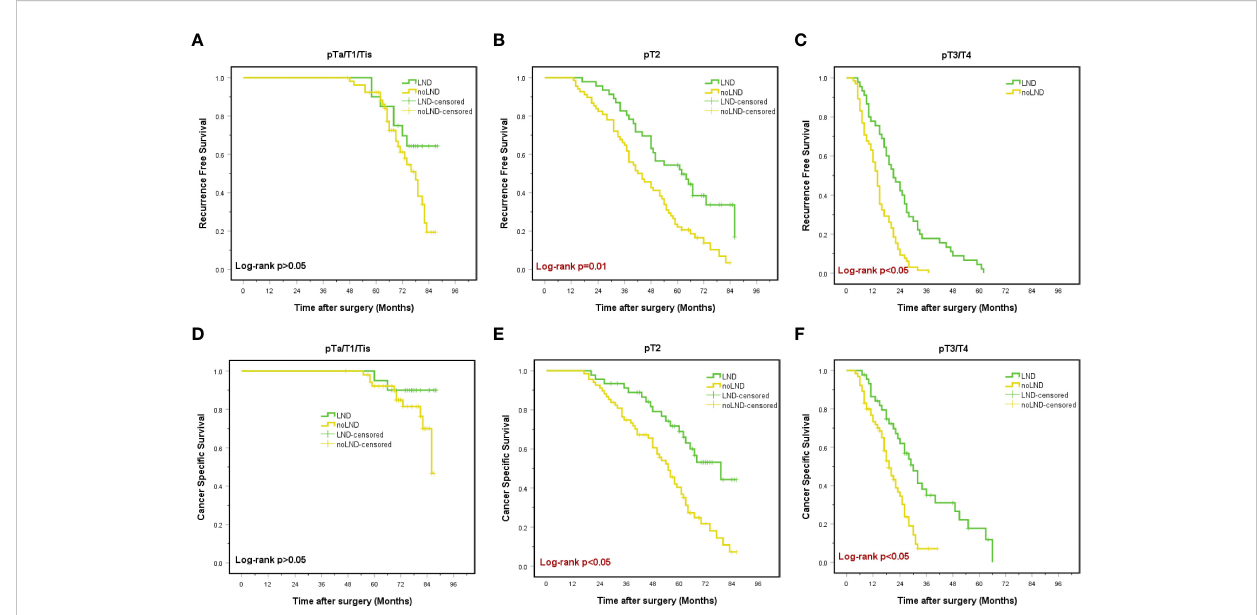
FIGURE 3 Kaplan-Meier curves for recurrence-free survival (A-C) and cancer-speci fi c survival (D-F) in subgroups strati fi ed by pathologic tumor (pT) stages. LND, lymph node dissection, Red font means P value <